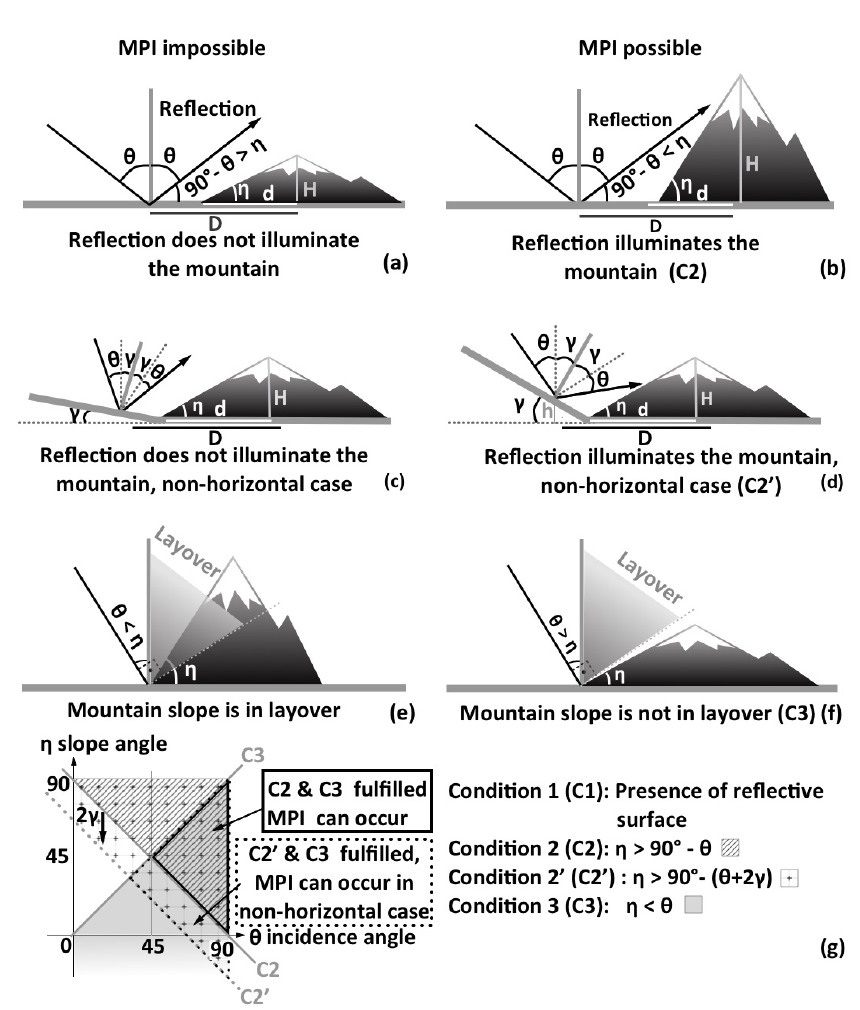
Figure 11. Conditions for the occurrence of MPI. ( a – f ) illustrate the geometrical requirements for the occurrence of multipath interference; ( g ) gives a visual and text summary of all geometrical and non-geometrical